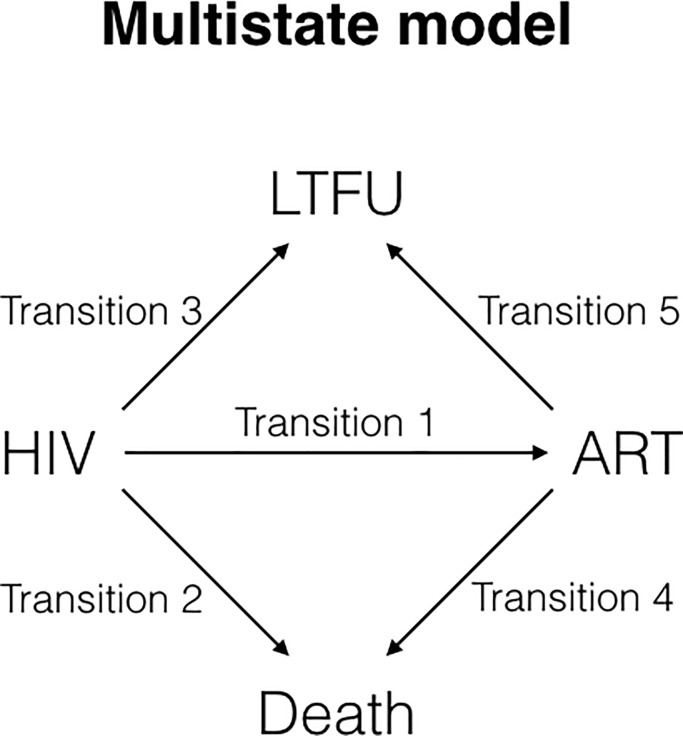
Multi-state model to assess LTFU.State definitions: (1) HIV state–started at the earliest recorded date of contact with the clinic for HIV testing, HIV test confirmation, or baseline interview; (2) ART state–started on the recorded ART start date or–when this information is missing–the earliest date in the pharmacy record of medicine pick-up. Individuals who received ART on the day they entered the clinic were modeled as starting directly in the ART state; (3) Death state–patients entered this state if their status is ‘Dead’ and the date of transition is the recorded date of death; (4) LTFU state–patients entered this state if the status is neither ‘Dead’ nor ‘Transferred.’ For patients who transitioned to LTFU from the HIV state, the date of LTFU is calculated as 90 days after the day the patient is expected to come back, i.e. 6 months or 183 days after the last recorded visit, so the date of LTFU is the date of the last recorded visit plus 273. For patients who transitioned to LTFU from the ART state, the date of LTFU is calculated as 60 days after the day the patient is expected to come back, i.e. 30 days after the last recorded visit (the LTFU date is the date of the last recorded visit plus 90 days); in cases where patients experienced multiple interruptions of 180 days or more, the date of LTFU is the date of the first interruption plus 90 days.